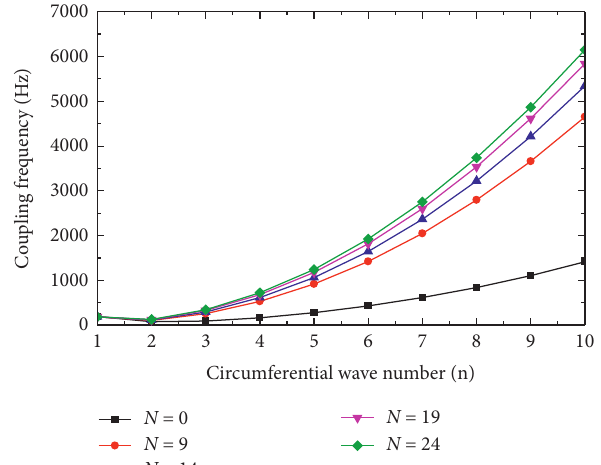
Figure 6: Coupling frequency curves of different number of ring